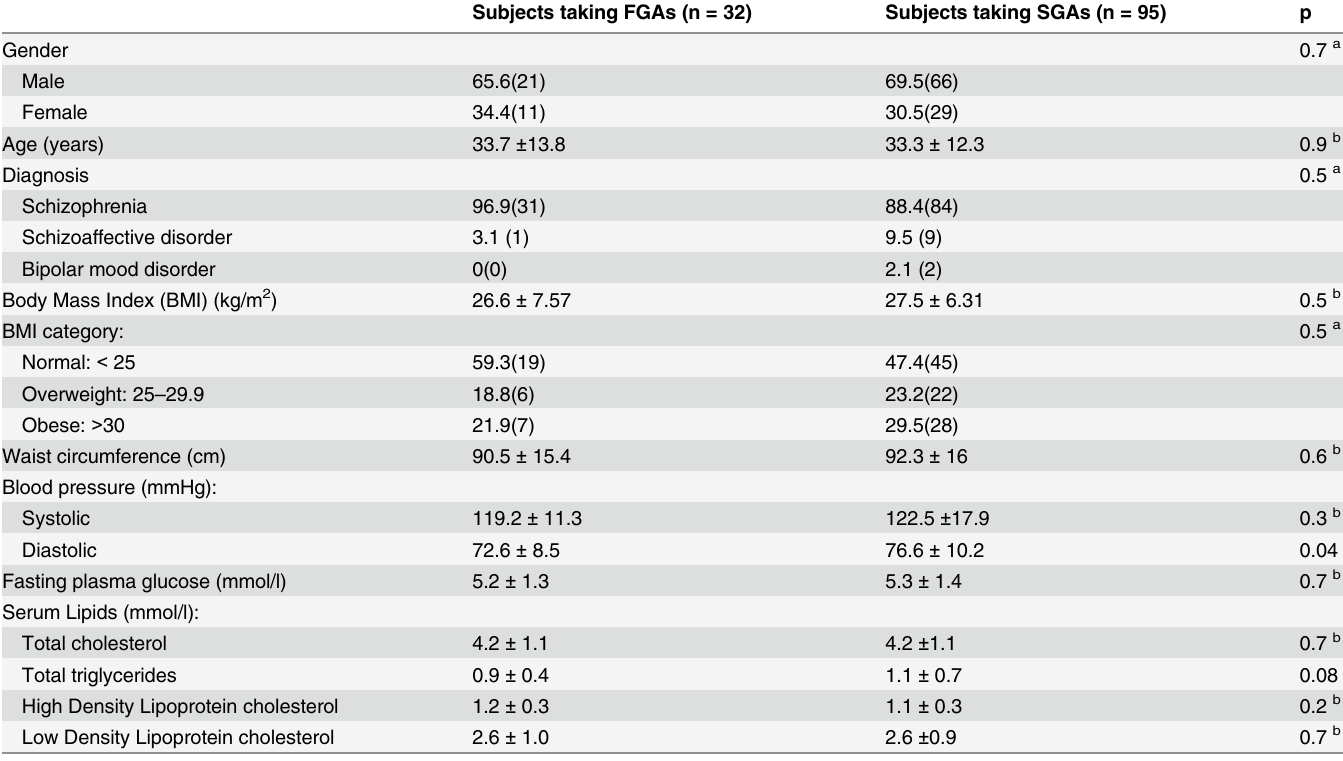
Table 4. Demographic and clinical characteristics of subjects with severe mental illness by class of antipsychotic medication in subjects on monotherapy.